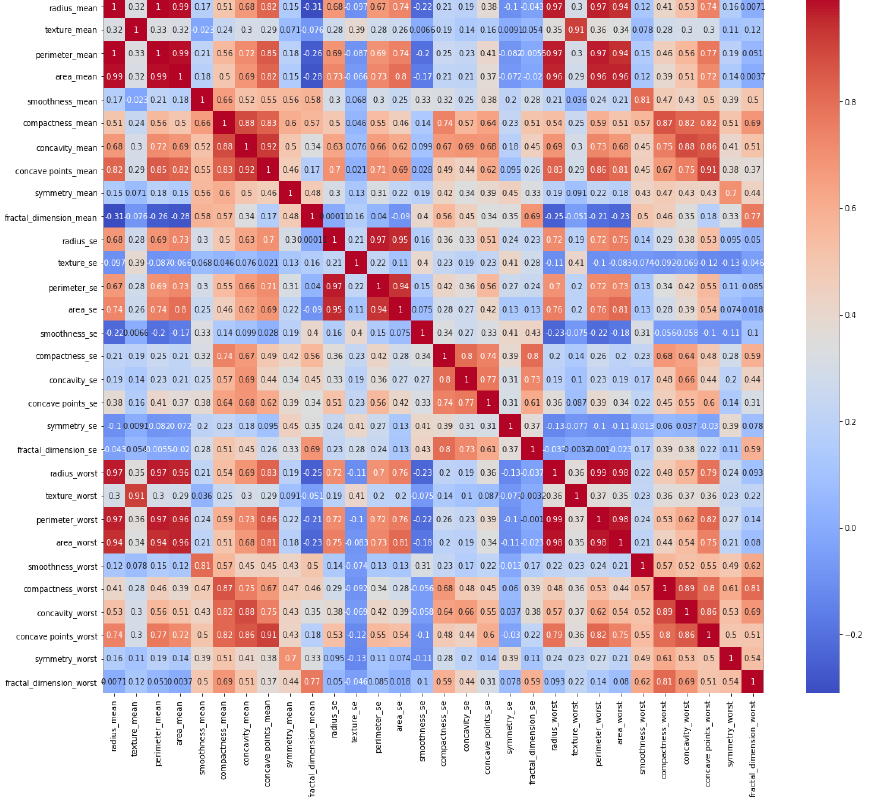
Figure 4. Heat map representative of independent variables.